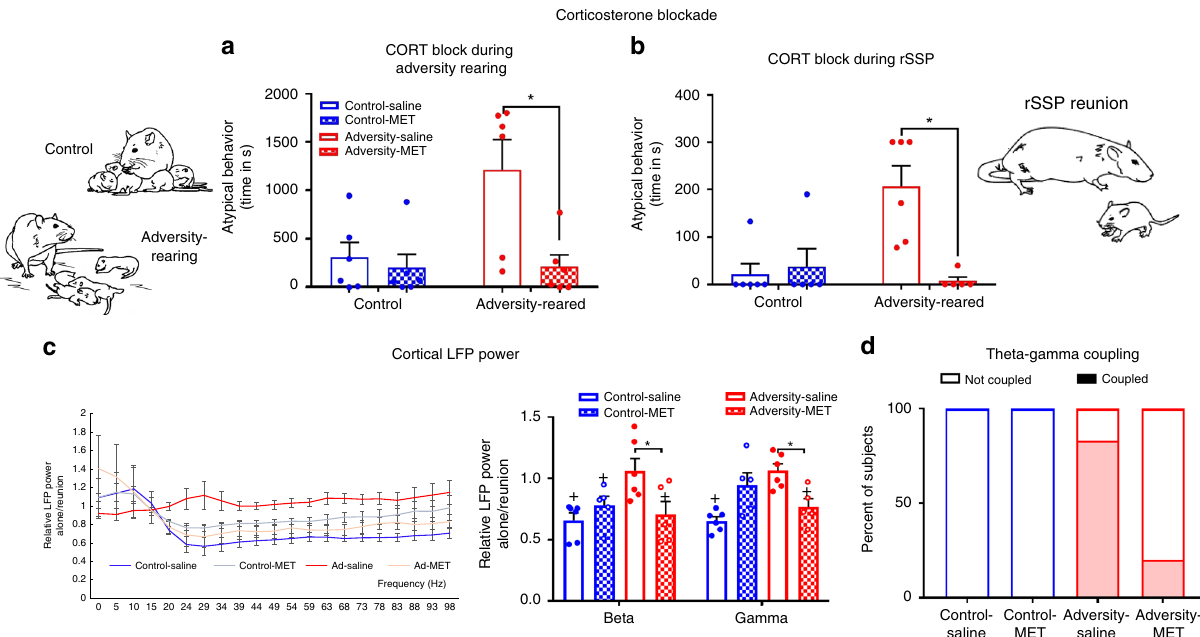
Fig. 6 Decreasing the stress hormone corticosterone (CORT) rescues maternal regulation of infant attachment behavior and cortical oscillations. a Blocking CORT synthesis during adversity-rearing prohibited expression of atypical behavior during a 30-min social behavior test outside of the nest. b Blocking CORT synthesis during SSP prevented expression of atypical attachment behavior during reunion with the mother. Ninety minutes before SSP, pups received the CORT synthesis inhibitor metyrapone (50 mg/kg) or saline. c In an internal replication of Exp. 1, saline-treated, adversity-reared pups failed to exhibit decreased beta and gamma oscillations upon reunion with the mother; this maternal regulation was restored if they were administered metyrapone before the test. Bars represent mean ± SEM of power collapsed into frequency bands. d CORT inhibition in maltreated pups restored control- like coupling during reunion with the mother in the rSSP. Dashed line = no change from baseline; + indicates mean signi fi cantly different from baseline (1). * p < 0.05, ANOVA. Source data are provided as a Source Data fi